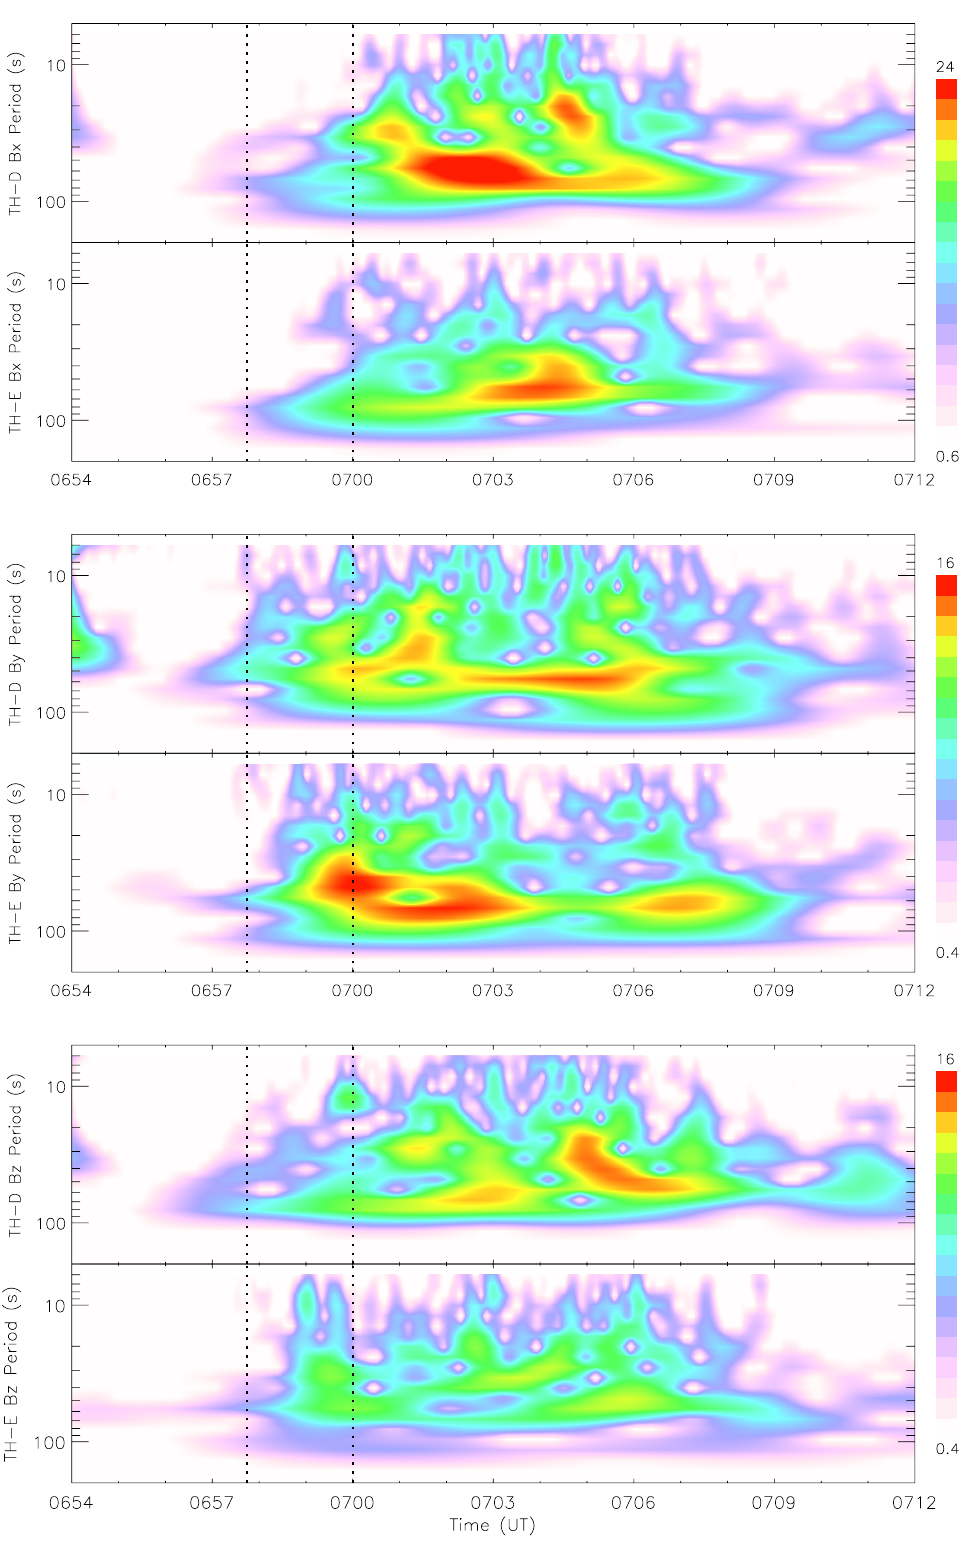
Fig. 7. Wavelet scalogram of the magnetic fields observed on TH-D and E. Two vertical lines indicate the time of EP onset and local CD onset,